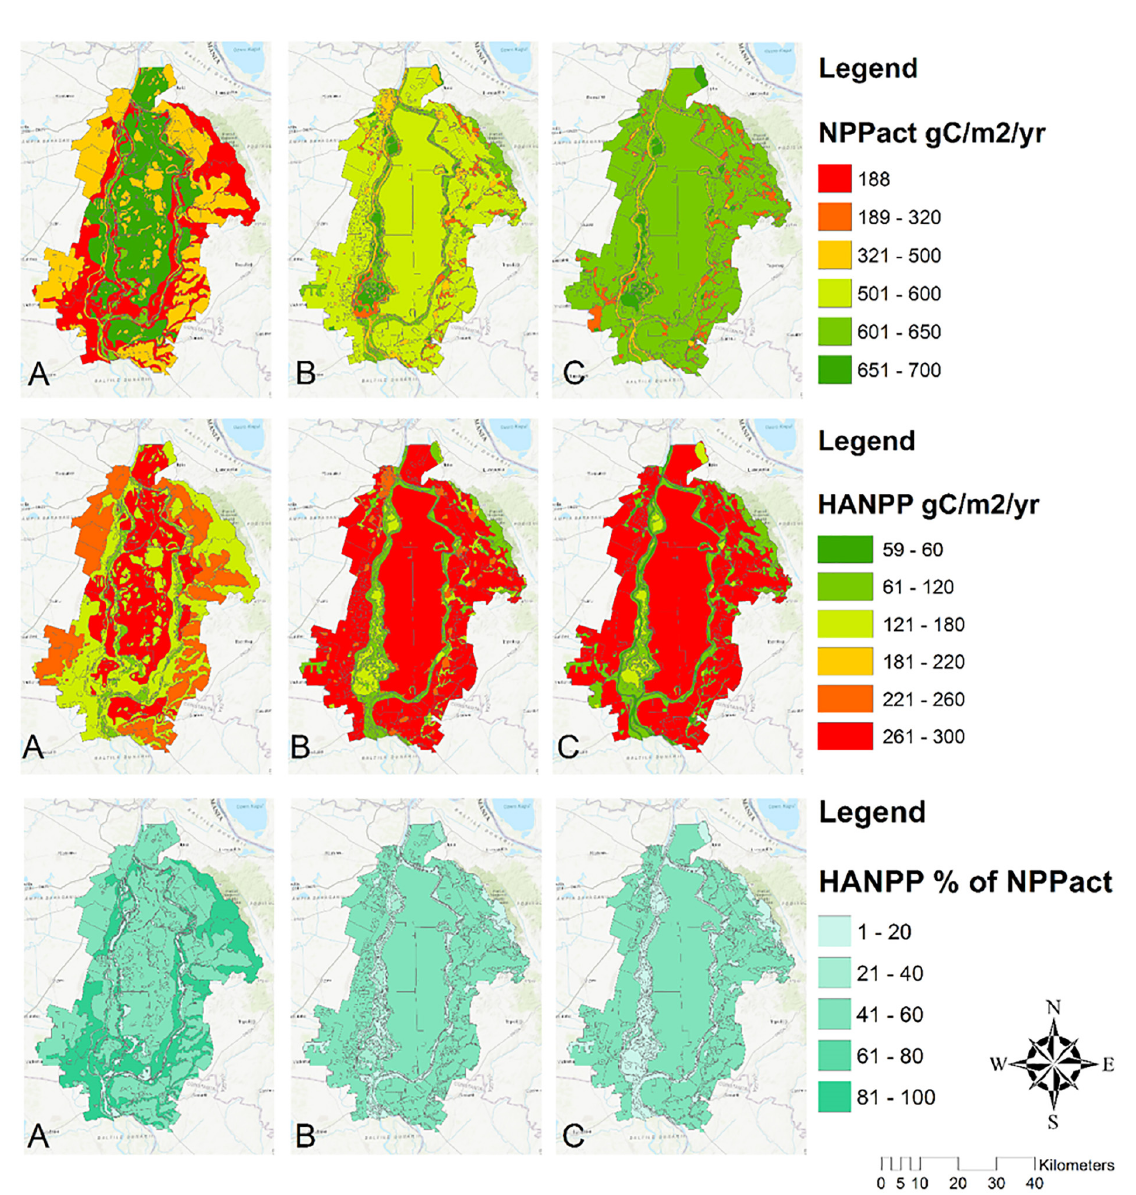
Figure 5. Spatial distribution of the HANPP indicators for the pre-communist ( A ), communist ( B ), and transitional and EU ( C ) periods.